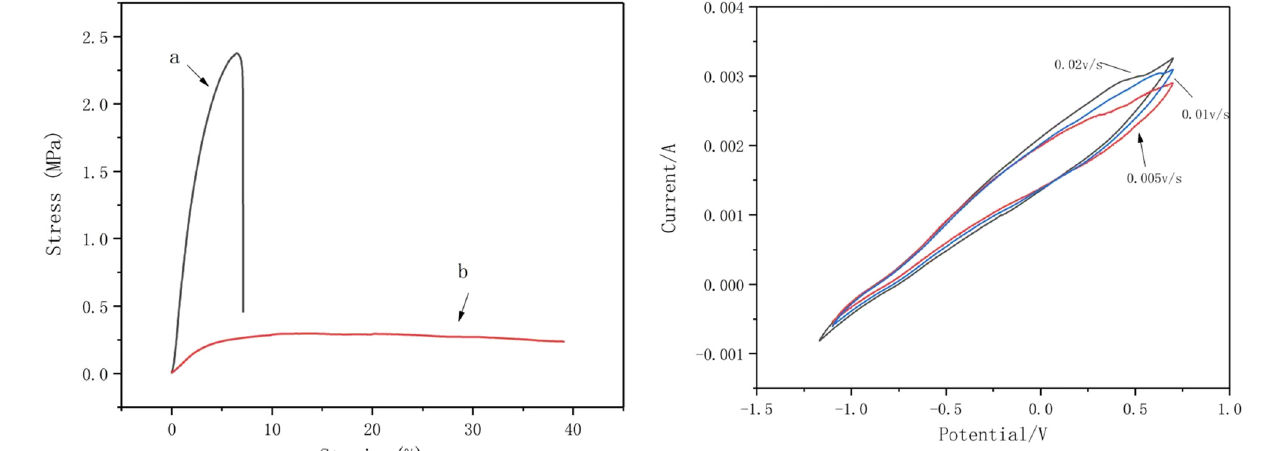
Figure 6: Stress – strain curve: ( a ) WPU membrane and ( b ) WPU/PANI composite membrane.